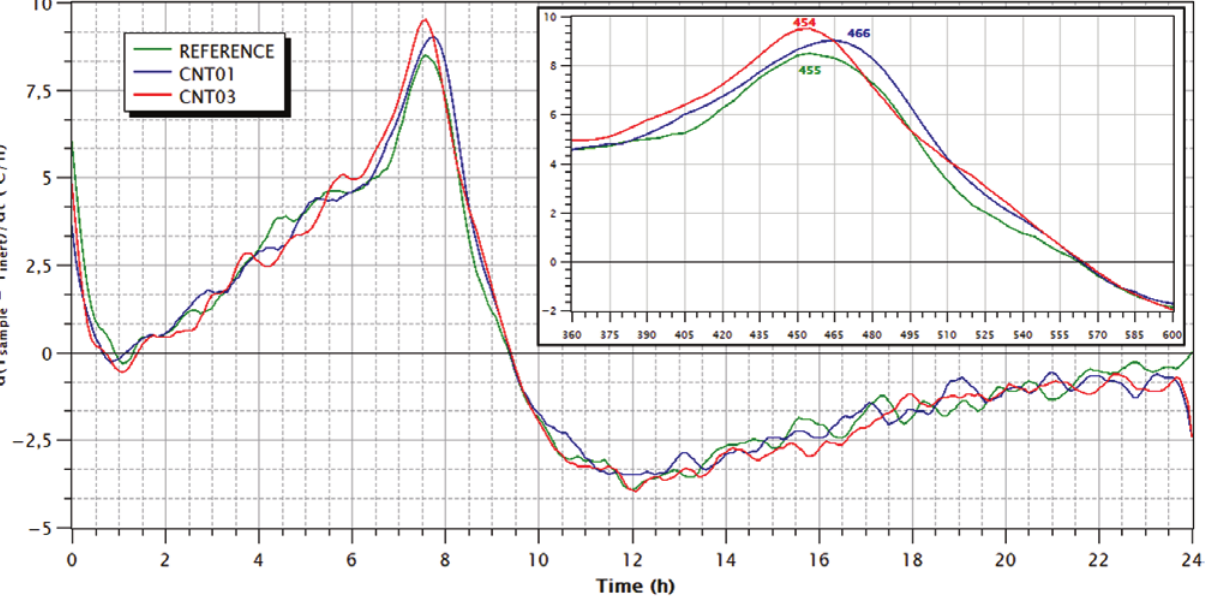
First derivative of the temperature profile versus time relationships for each type of cement paste